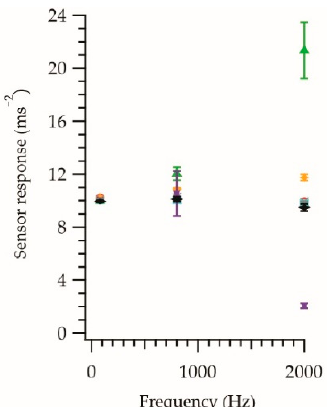
Figure A1. Accelerometer response when attached to the vibration stage using the screw , Tesa 51571 white double-sided cloth tape , 3M 4026 white foam tape , 3M 9088 transparent double sided plastic tape , 3M scotch 9536 white foam tape , 3M 4910F VHB™ clear foam tape and beeswax at different frequencies with a vibration amplitude of 10 ms − 2 .